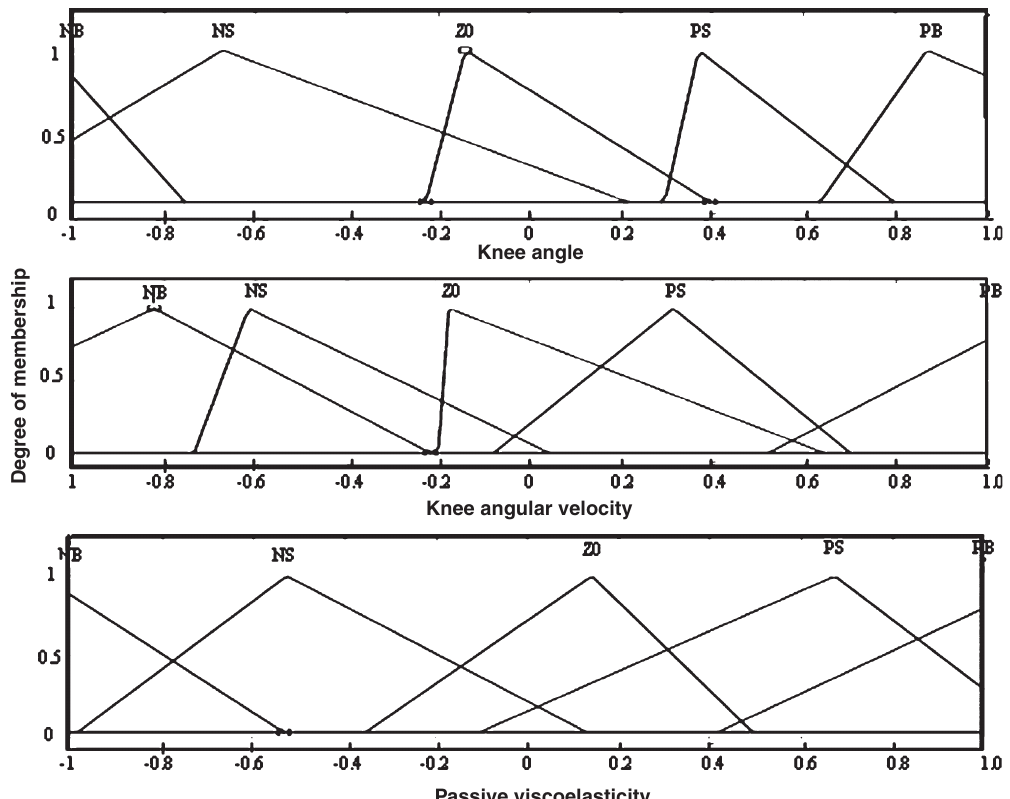
Fig. 7. Optimised membership functions of passive viscoelaslacity model.